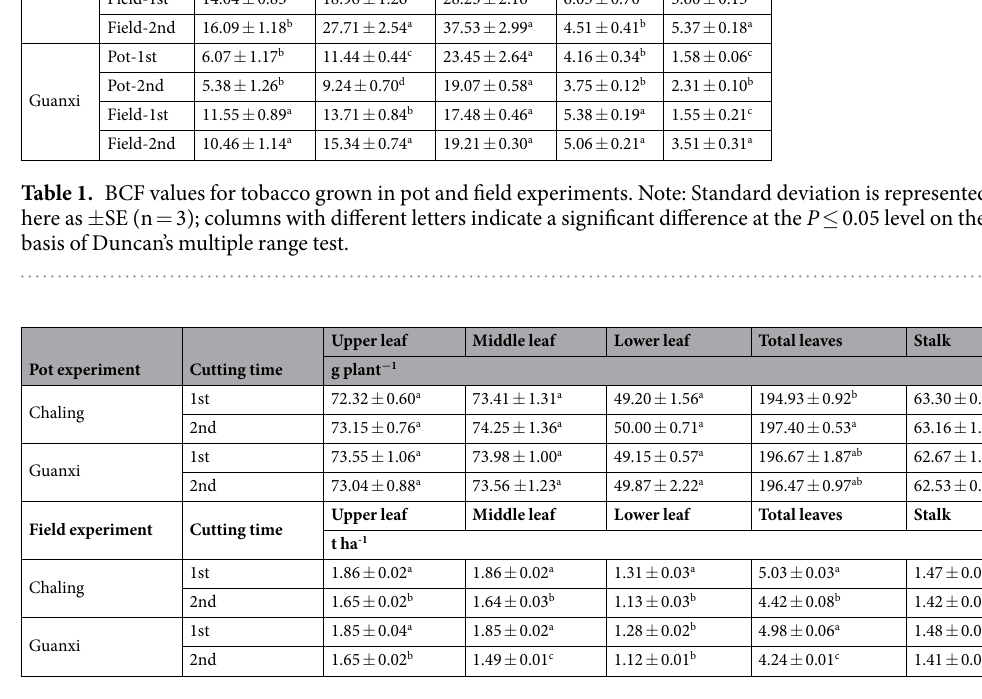
Table 2. Biomass of tobacco leaves and stalks. Note: Standard deviation is represented as ± SE (n = 3); columns with different letters indicate a significant difference at the P ≤ 0.05 level on the basis of Duncan’s multiple range